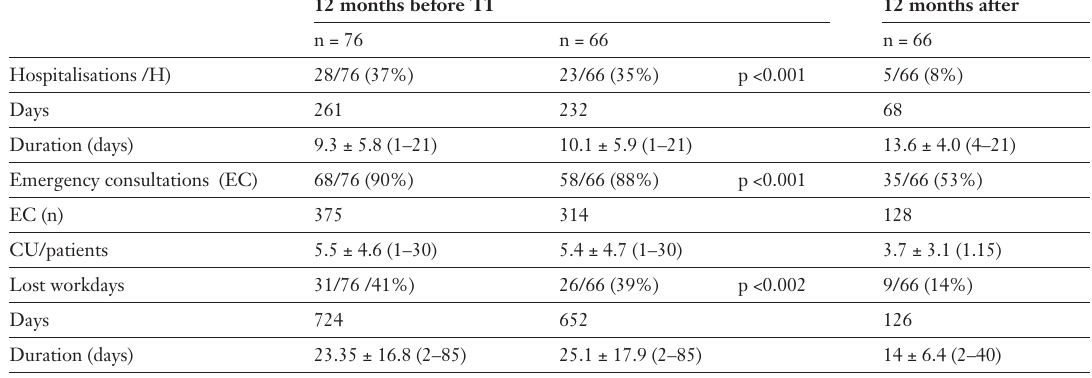
Morbidity and re- source consumption 12 months before and 12 months after therapeutic inter- vention